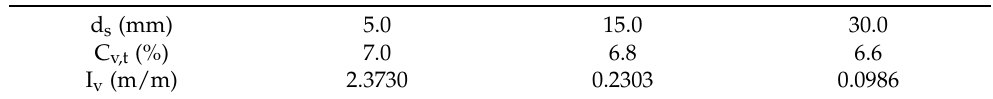
Table 4. Relationship between total pressure drop and particle diameter at V mix ,0 = 4.0 m/s and C v ,0 = 5%.